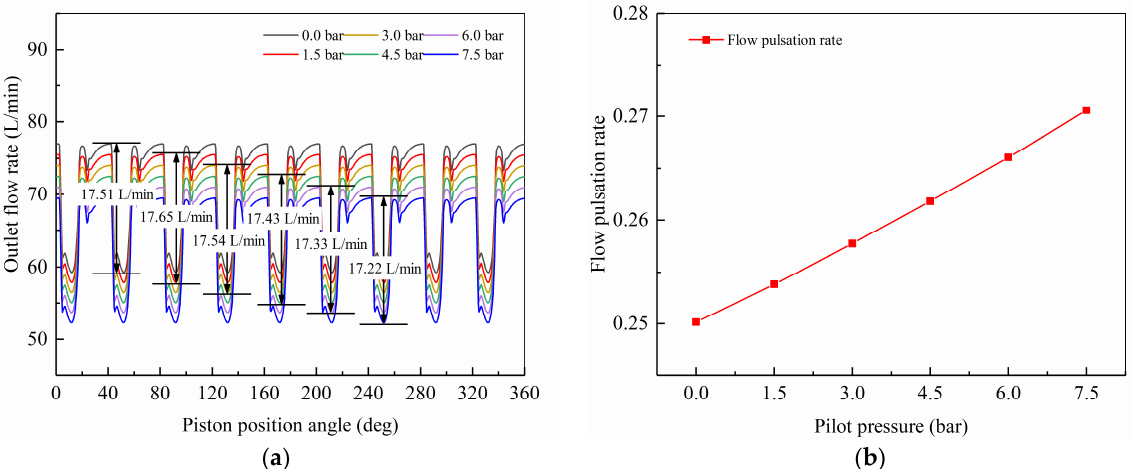
Figure 29. Outlet flow pulsation and pulsation rate under different power control pilot pressures: